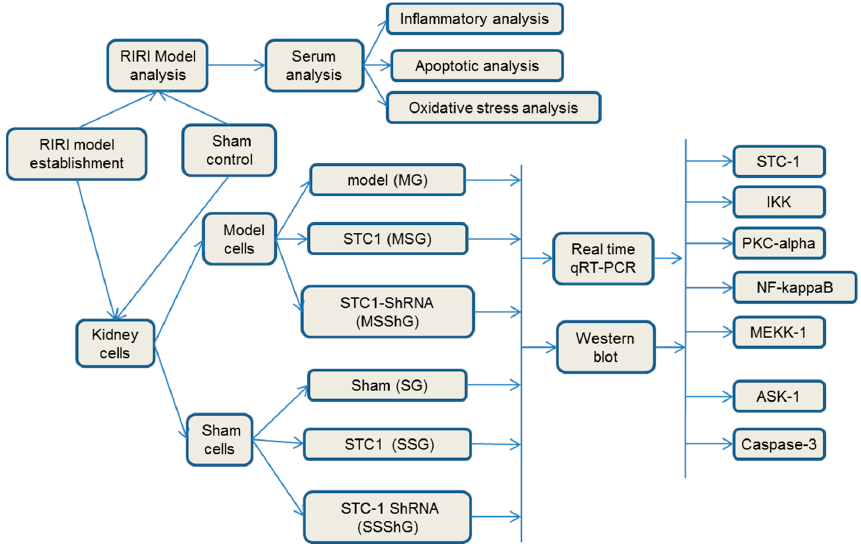
Figure 7. The flowchart of the study. Among 16 mice, eight mice were used to create RIRI models as a model group and another eight mice were used as a sham group. The RIRI model was evaluated